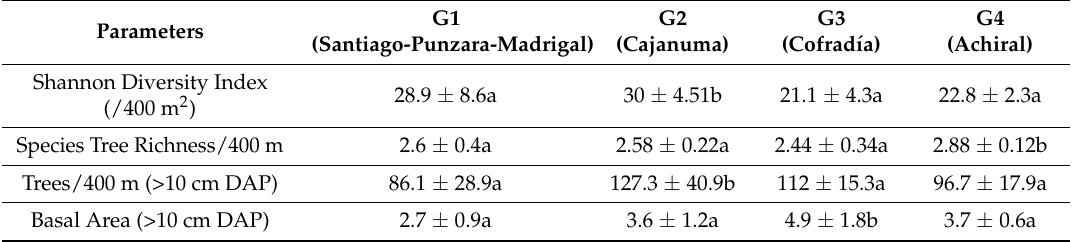
Table 6. Structural parameters and diversity of montane forest in Southern Ecuador. The mean value ± SD is shown; different letters show significant differences ( p ≤